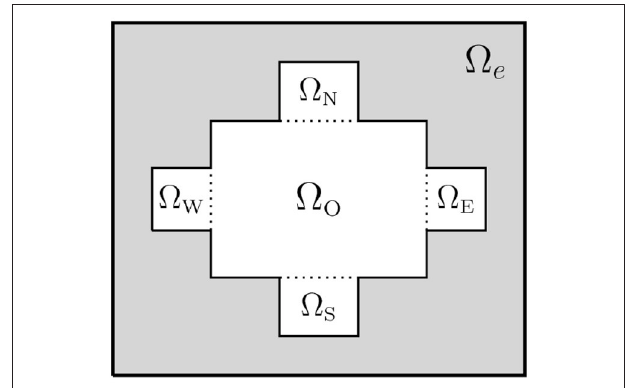
FIGURE 4 | Sketch of the 2D version of a domain in the case of a single cell. Here, (cid:127)